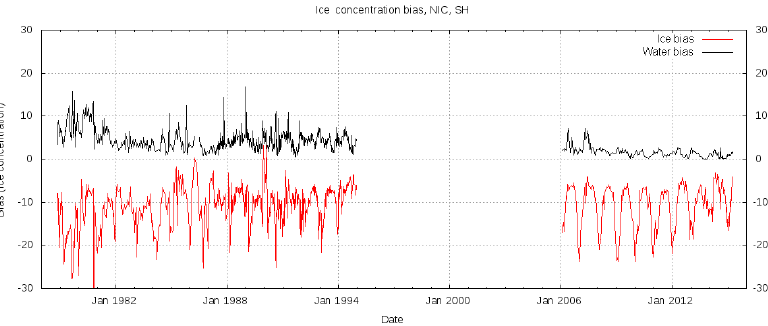
Figure 6. The Antarctic ESICR-NIC ice chart mean difference (bias) for areas of ice in red and for areas of open water in black. No ice charts were available to us from 1994 to